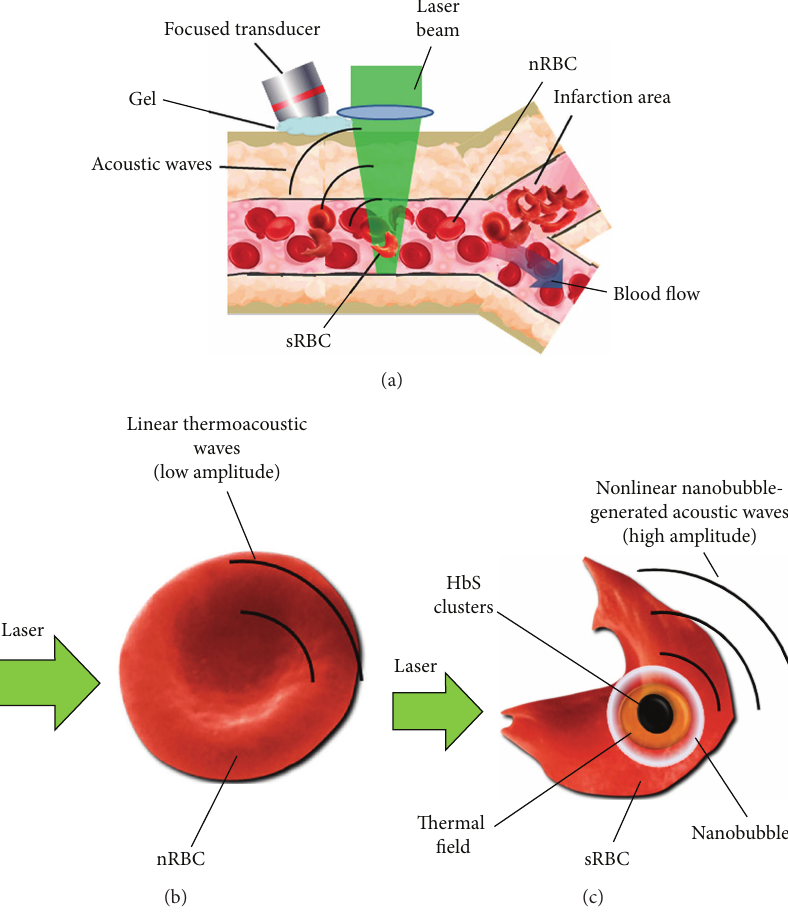
Figure 1: Principles of PA monitoring of sRBCs during SCD crisis. (a) Schematic of PAFC. (b, c) Principles of linear (b) and nonlinear nanobubble-based (c) PA detection of relatively homogenous HbA and clustered HbS distribution in normal and sickled cells (nRBCs and sRBCs),